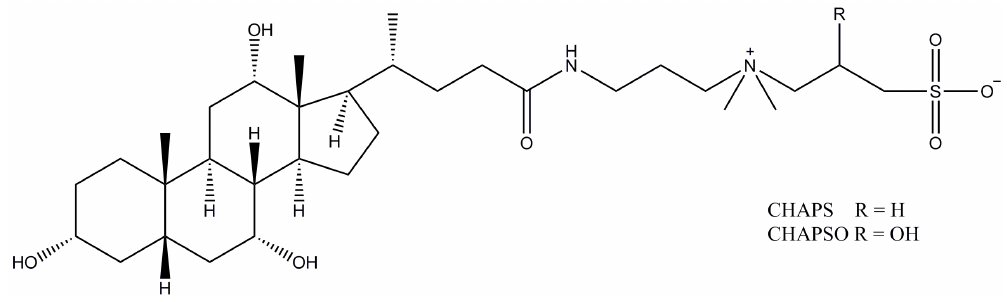
Figure 14. Structure of CHAPS and CHAPSO (chemical formula is C 32 H 58 N 2 O 7 S / C 32 H 58 N 2 O 8 S).